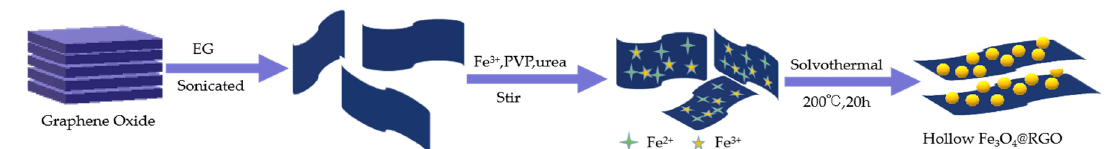
Figure 1. Schematic illustration of the fabrication of the hollow Fe 3 O 4 @reduced graphite oxide (RGO) nanocomposites.